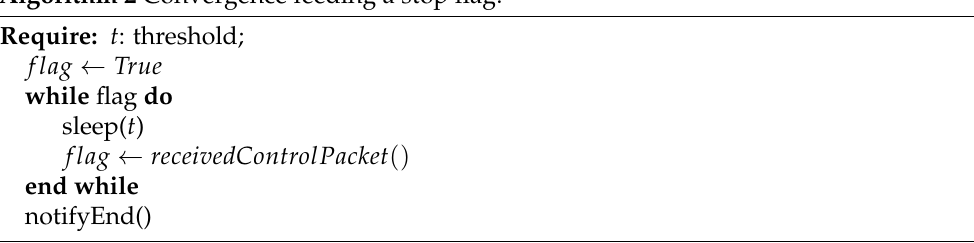
Algorithm 2 Convergence feeding a stop